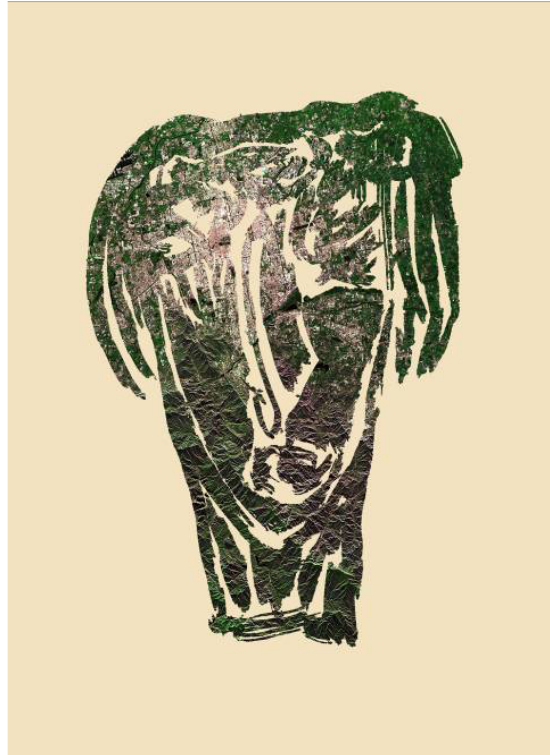
Figure 2 Tamer Assem – Beijing Man – Digital Print – 70x50cm –